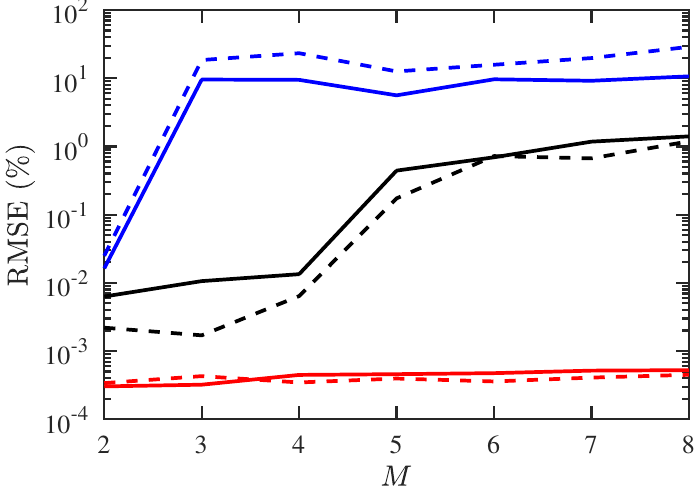
Figure 4. RMSE of DOA and CF estimation under different numbers of signals, SNR = 10 dB, Q = 300, M u = 1. ———: RMSE of DOA with proposed PJE algorithm, − − − : RMSE of CF with